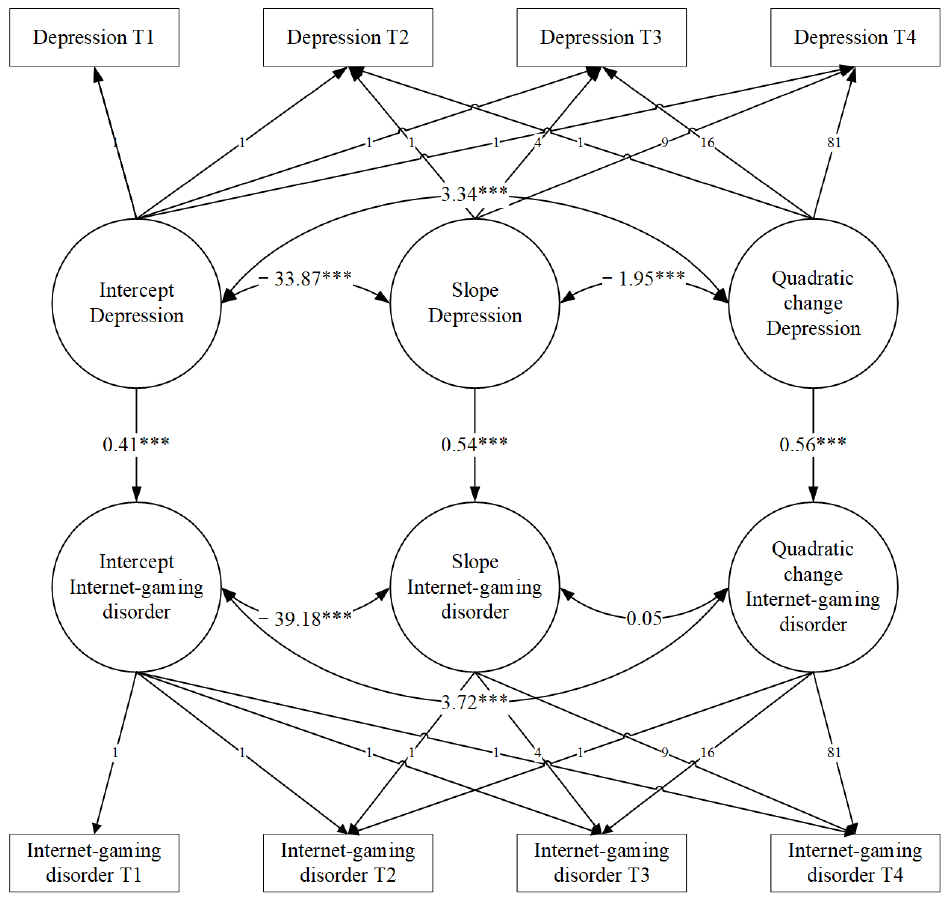
Figure 4. Unconditional LGM with multiple growth process of depression and Internet gaming disorder. *** p < 0.001.